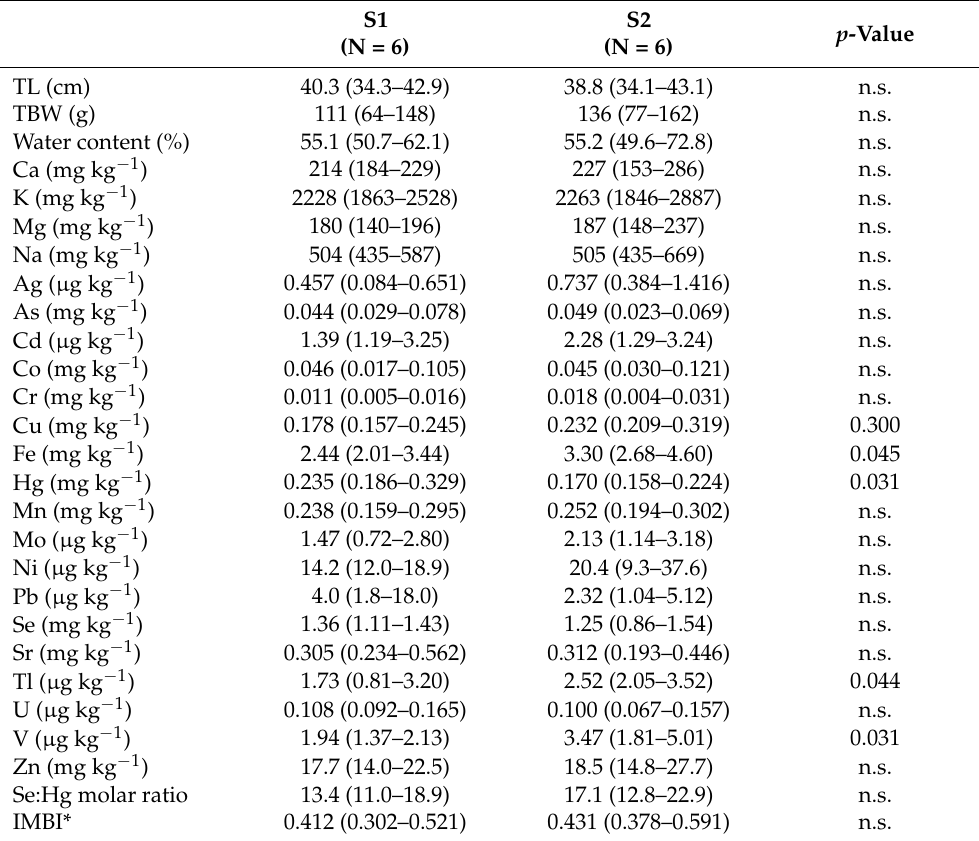
Biometric parameters, water content (%) and average concentrations of elements (in mg kg − 1 or µ g kg − 1 wet weight), Se:Hg molar ratios and IMBI [median (range)] in the muscle tissue of the European eel from the Raša River grouped by